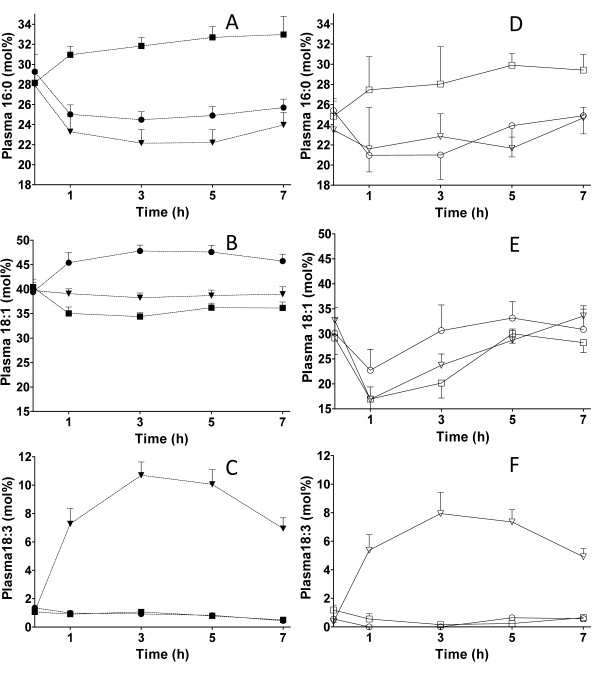
Mean FA composition (mol% ± SEM) in p-TAG (n = 10): A: palmitic acid (16:0), B: oleic acid (18:1), C: ALA (18:3) and p-NEFA (n = 10):D: palmitic acid, E oleic acid, and F ALA, in women after meals containing 35 g fat from ALA-rich oil, olive oil or butter fat. P-TAG: ALA-rich oil (--▼--), olive oil (--●--) butter (--■--). P-NEFA: ALA- rich oil (-∇-), olive oil (-○-) butter (-□-). The AUCs for the FAs that differed significantly between the meals are given in Table 4. Significance (P < 0.05, ANOVA and Bonferroni multiple comparison post hoc test).